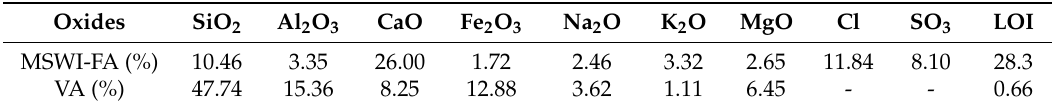
Table 2. Chemical composition of MSWI-FA and